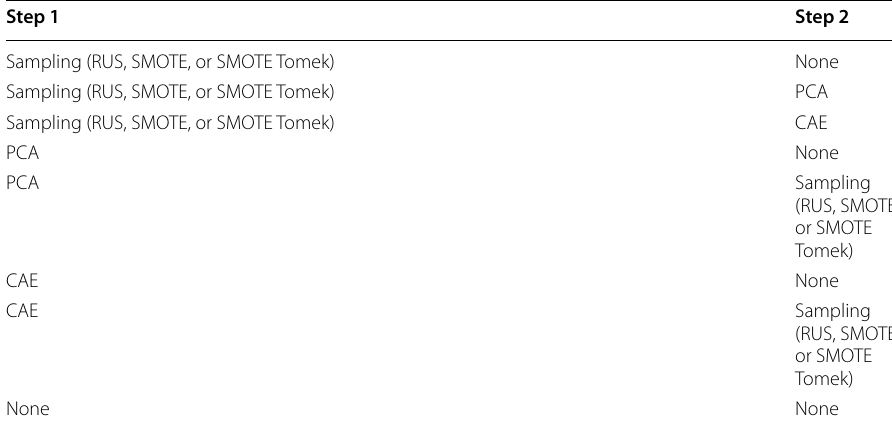
Table 1 Preprocessing scenarios